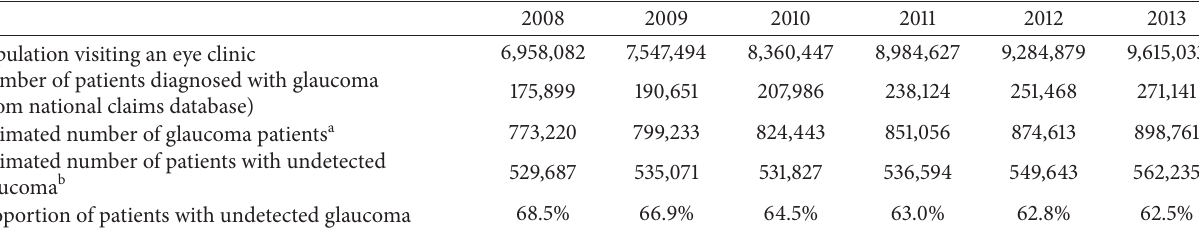
Table 5: Estimated prevalence of undetected glaucoma.